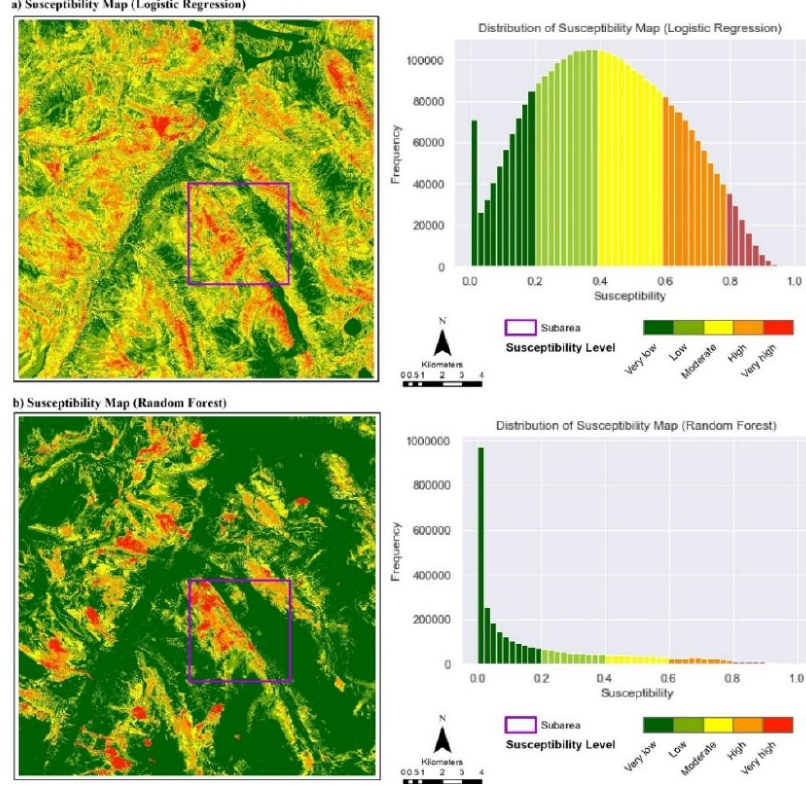
Figure 8. Avalanche susceptibility maps and distributions of LR (a) and RF model